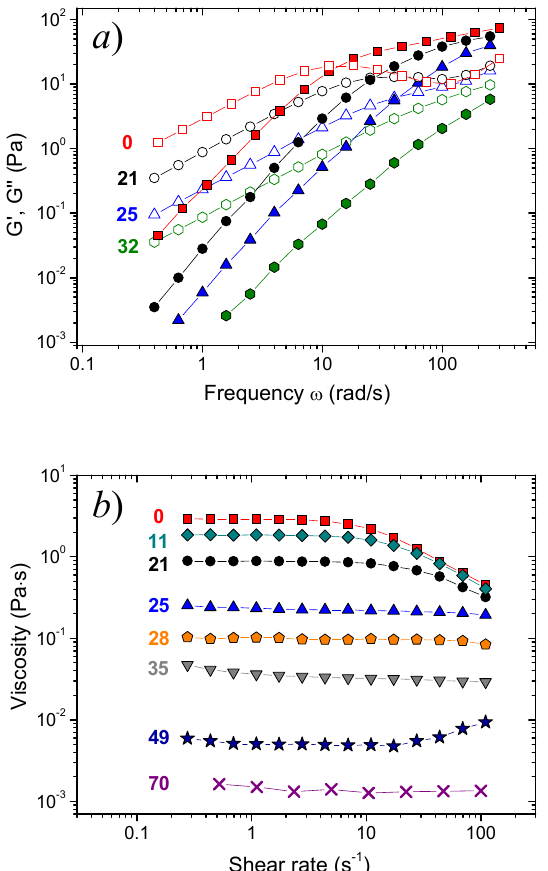
Figure 1. Frequency dependences of storage G’ (filled symbols) and loss G” (open symbols) moduli ( a ) and dependences of viscosity on shear rate ( b ) for aqueous solutions containing 117 mM C8TAB, 78 mM potassium oleate, and different amounts of added n-decane indicated in the figures (in mM), at 20 °C.